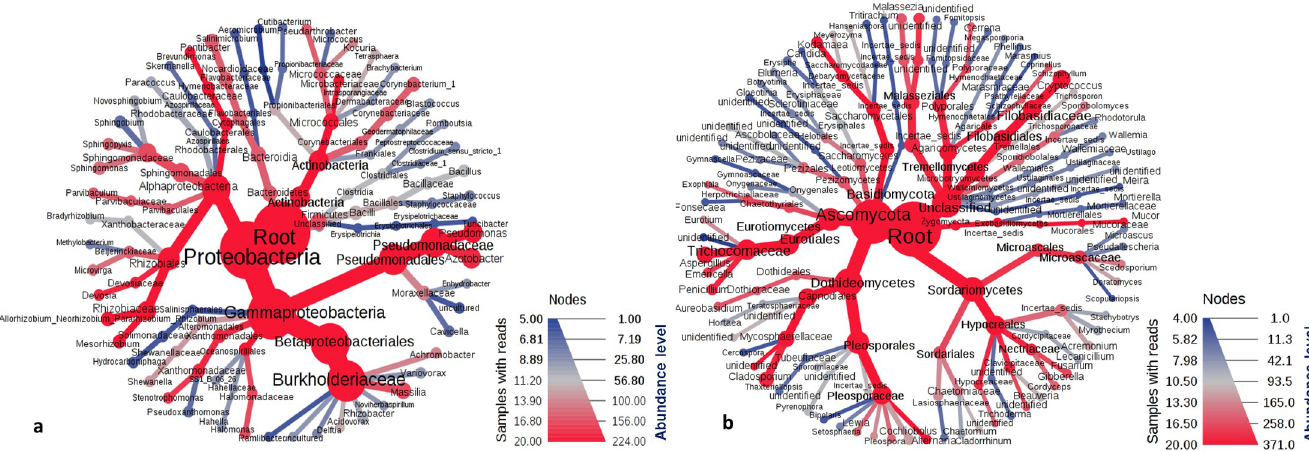
Fig 1. Taxonomic distribution of microbial populations associated with dust aerosols in Kuwait, (a) Bacterial; (b) Fungal. A differential heat tree was plotted to depict the commonly abundant taxa in terms of relative abundance. The nodes in red highlight the constantly detected genera, families, orders, classes and phyla.